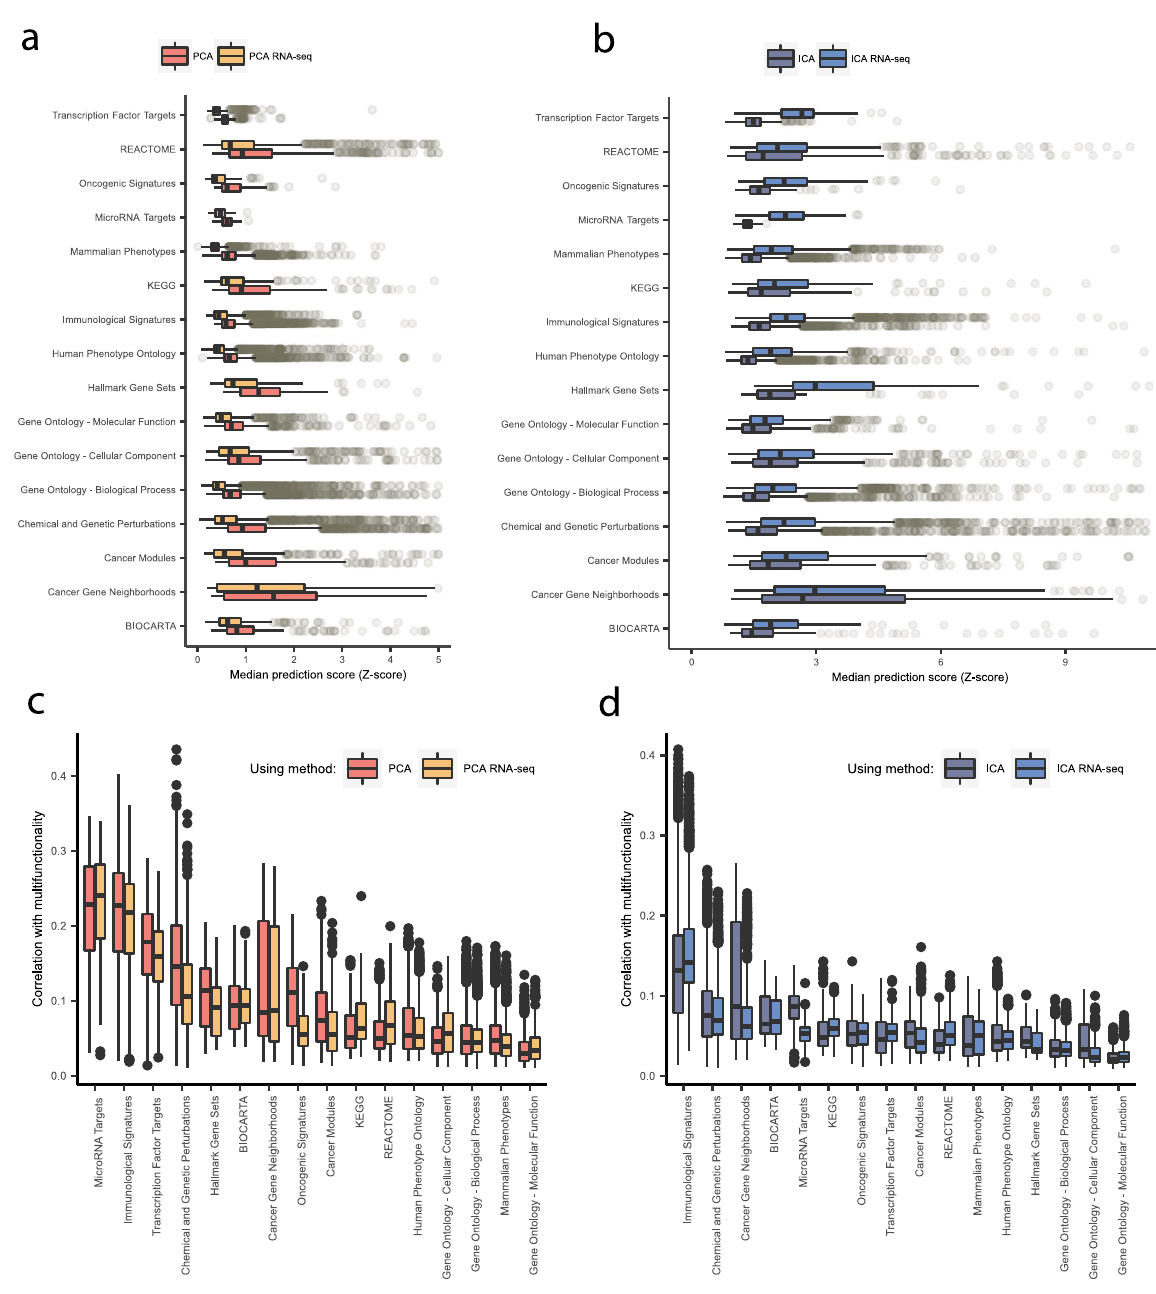
Fig. 9 Median prediction scores and multifunctionality association for RNA-seq-based predictions. a , b Boxplot of median prediction scores ( x -axis) calculated by applying the PCA-TC-based ( a ) or ICA-TC-based ( b ) method to microarray (red and dark blue) and RNA-seq (yellow and blue) input data for each of the 16 gene set collections ( y -axis). Median prediction scores are calculated separately for each gene set using both RNA-seq and microarray input datasets for member genes. Prediction scores of PCA-TC-based method tend to be higher when using the microarray input dataset. Prediction scores of ICA-TC-based method tend to be higher when using the RNA-seq input dataset. c , d Boxplot of distance correlation between PCA-TC-based ( c ) or ICA- TC-based ( d ) gene set prediction scores and the gene set collection multifunctionality score ( y -axis) for each gene set collection ( x -axis). Predictions are calculated using microarray and RNA-seq input datasets. The magnitude of correlation varies across gene set collections and between gene sets in a collection. The PCA-TC and ICA-TC-based methods have comparable multifunctionality association when using RNA-seq and microarray input data for most gene set collections. Predictions obtained using the ICA-TC-based method have a lower association to multifunctionality for the microRNA Targets and Cancer Gene Neighborhoods gene set collections when using RNA-seq data as input. Hinges of boxes represent second and third quartiles and whiskers extend by half that interquartile range. Center of box corresponds to collected from GEO. All available samples hybridized to Affymetrix HG-U133 Plus Transcription Factor Targets, Cancer Gene Neighborhoods, Cancer Modules, 2.0 (GPL570) were included (April 2018). Oncogenic Signatures, Immunological Signatures, GO-Cellular Component, GO- Molecular Function, GO-Biological Process). In addition, we obtained two gene set collections from other sources: The Mammalian Phenotypes and Human Pheno- Quality control and preprocessing . To identify samples that have been uploaded to type Ontology. We discarded from further analysis gene sets that contained <10 or >500 genes. Publicly available raw microarray expression data (CEL fi les) were GEO multiple times, we generated an MD5 hash for each individual CEL fi le, after